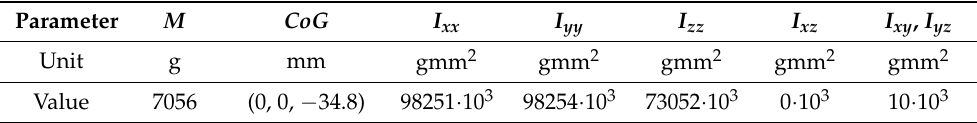
Table 2. Inertial specifications of the sphere model (in the local coordinate system) .